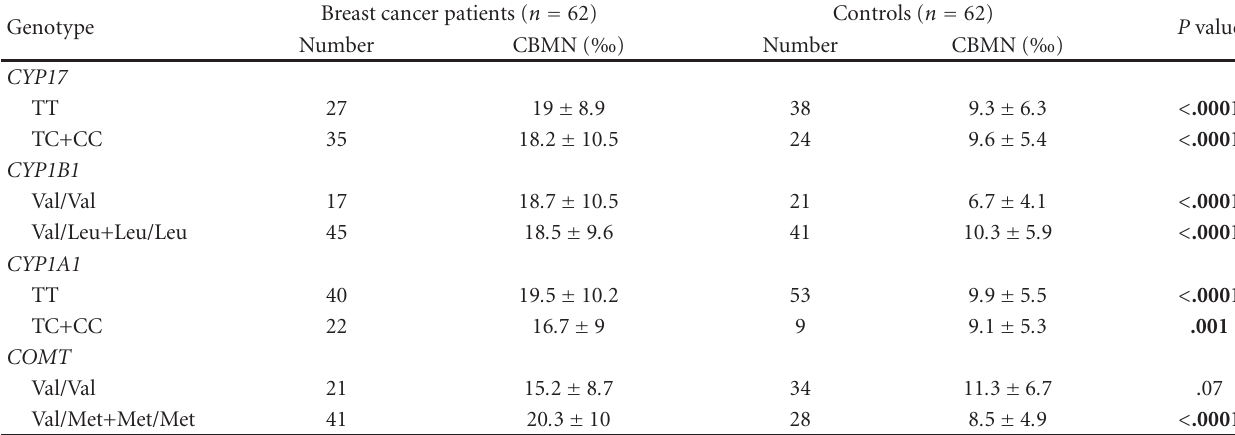
Table 3: Frequency of micronucleated cells in untreated breast cancer women and controls with di ff erent genotypes.